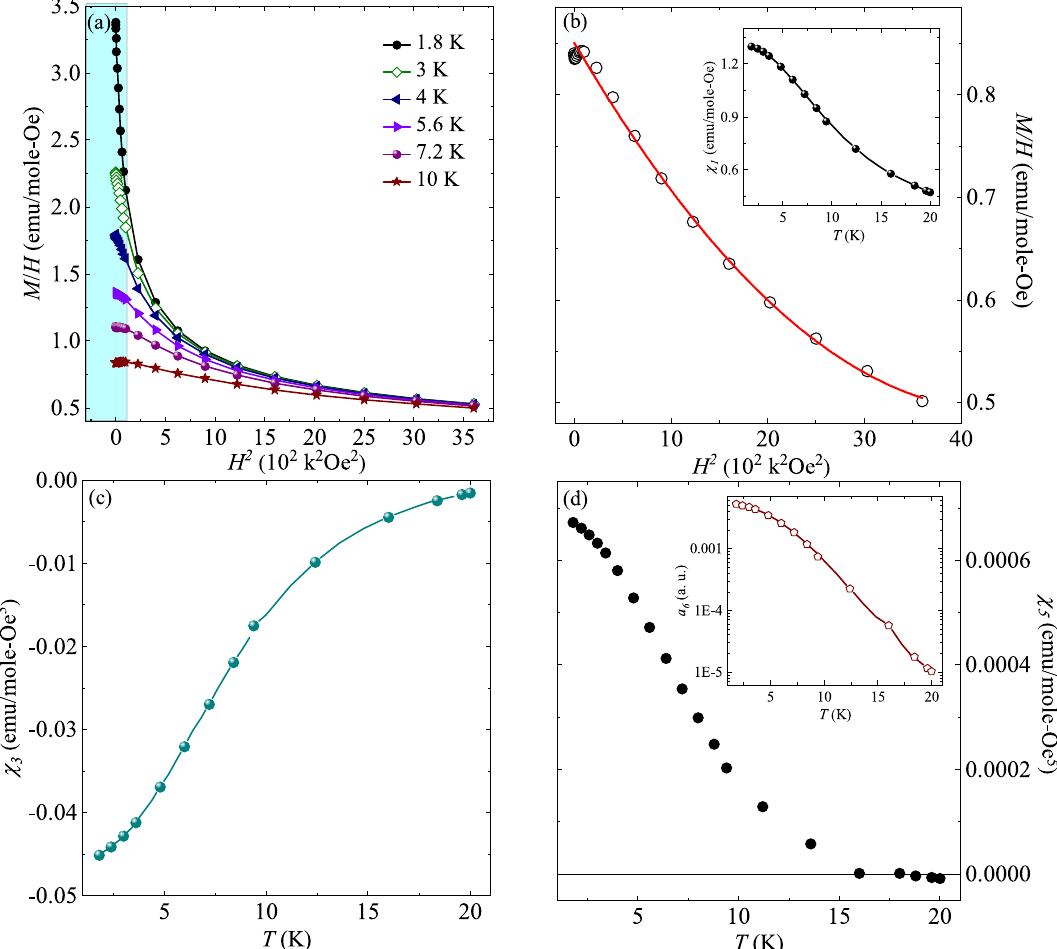
Figure 4. ( a ) M / H vs H 2 curves plotted at various temperatures. The shaded region below 10 kOe shows the deviation from quadratic-like behaviour. ( b ) M / H versus H 2 curve at 10 K, with solid red line showing the fit to the Eq. (3). The inset of ( b ) shows the temperature response of linear term χ 1 . ( c , d ) Temperature response of χ 3 and χ 5 extracted from the non-linear DC susceptibility data. The inset of ( d ) shows the quantity 7 a 6 3 χ 2 3 − χ 5 χ 1 ] /χ 1 plotted as a function of = [ (cid:31)